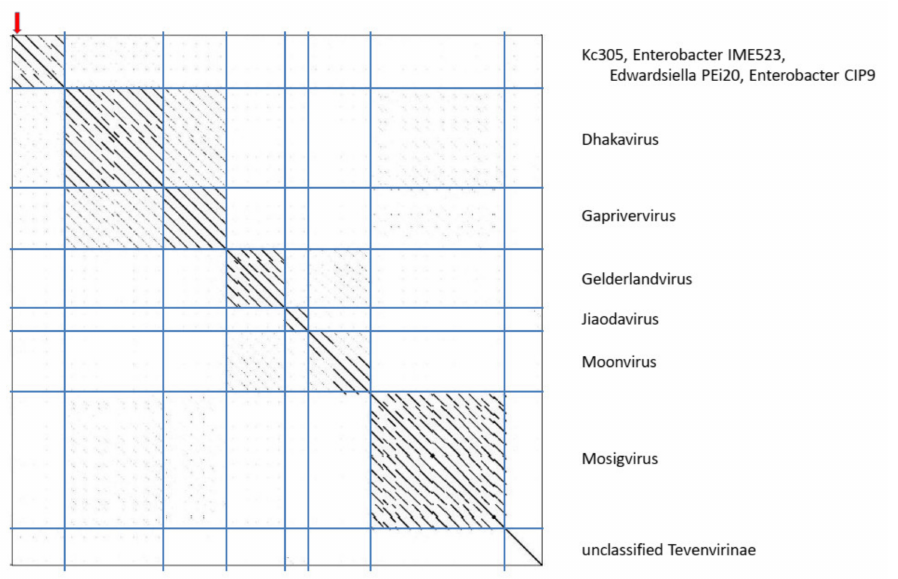
Figure 9. Genome structure and annotation of the Kc305 virus.